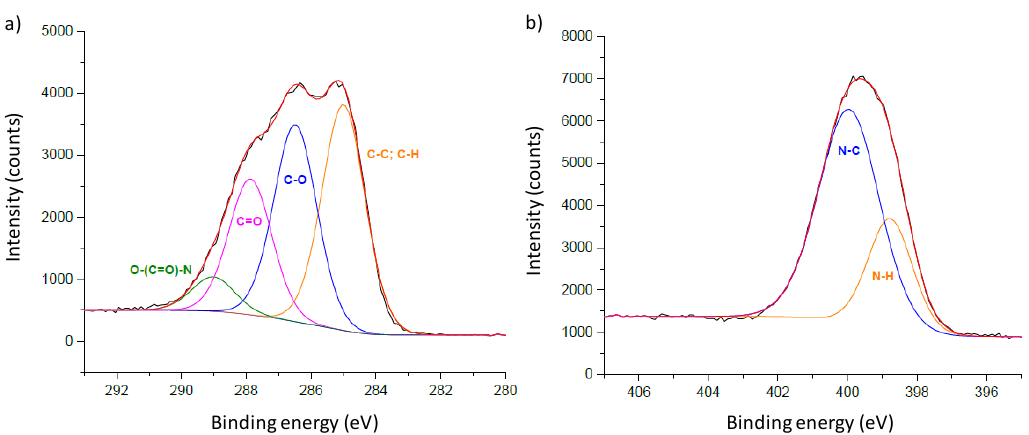
Figure 5. The X-ray Photoelectron Spectroscopy (XPS) Carbon ( a ) and Nitrogen ( b ) high-resolution spectra of N1 thin film deposited onto Si.